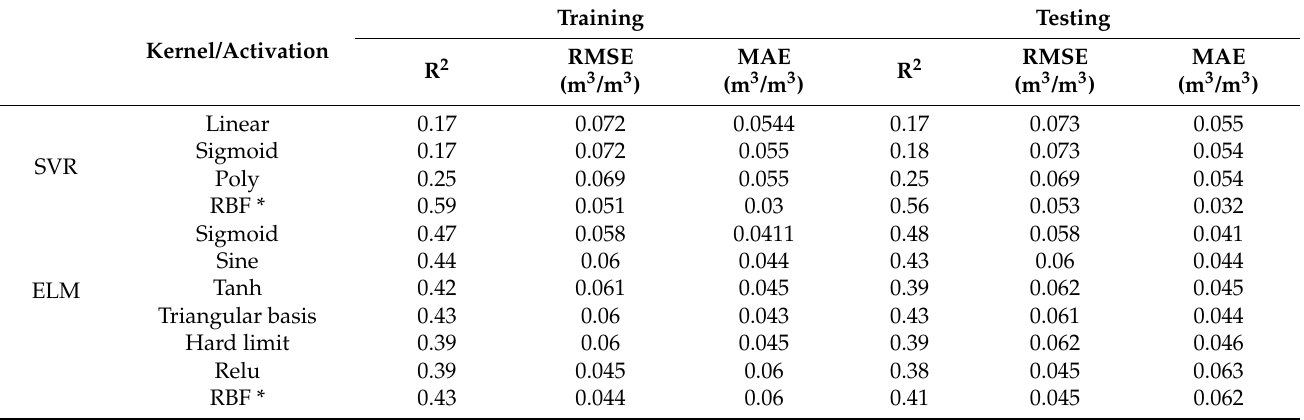
Table 3. Results of Support Vector Regression (SVR) and Extreme Learning Machines (ELMs) for training and testing